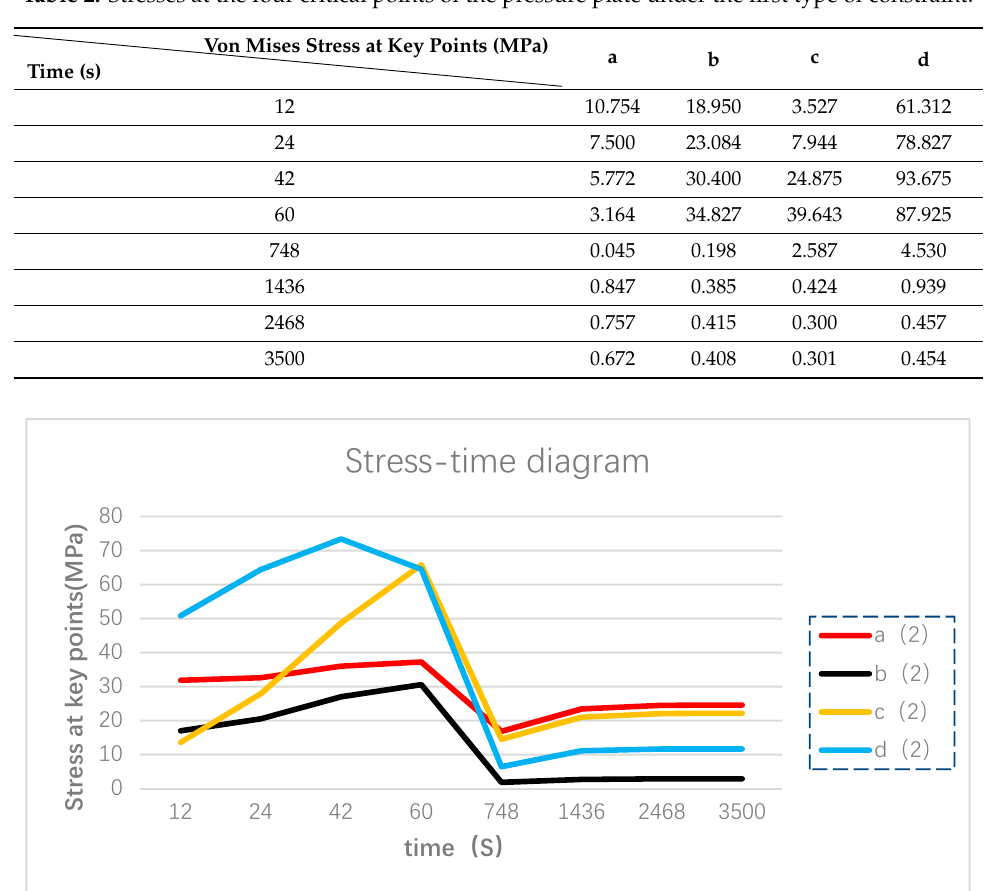
Figure 11. Stress at the four critical points of the pressure plate under the second type of constraint. Table 3. Stresses at the critical points of the pressure plate under the second type of constraint. Stress at Key Points